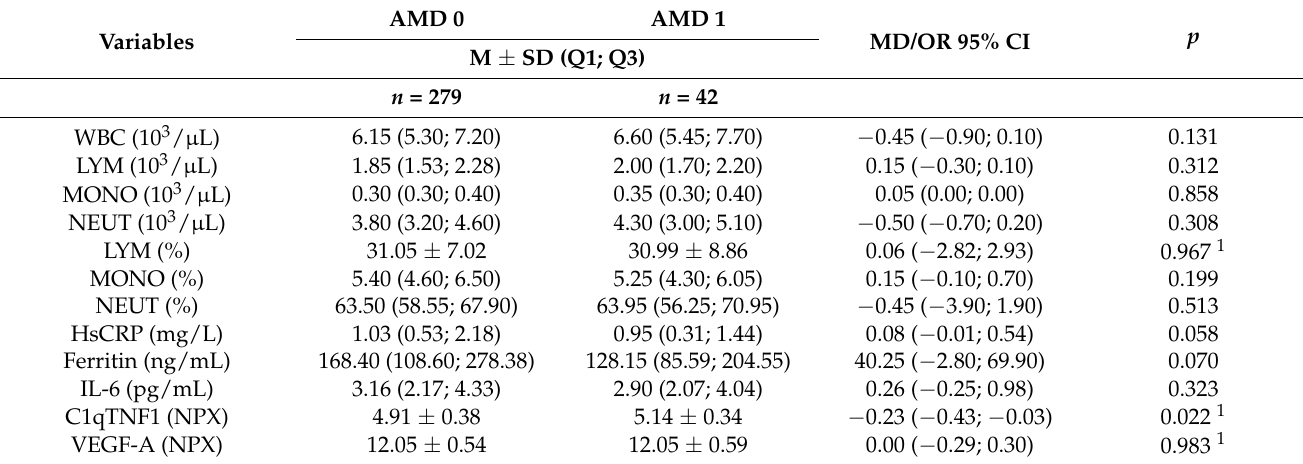
Table 3. Characteristics and comparisons of AMD 0 and AMD 1